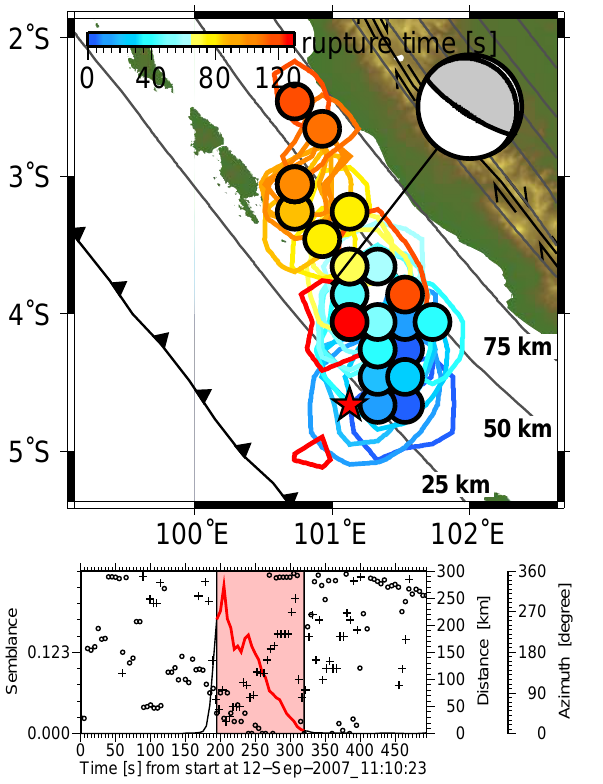
Fig. 4. As in Fig. 3 but for the nearby M 8 . 0 earthquake on 12 September 2007,